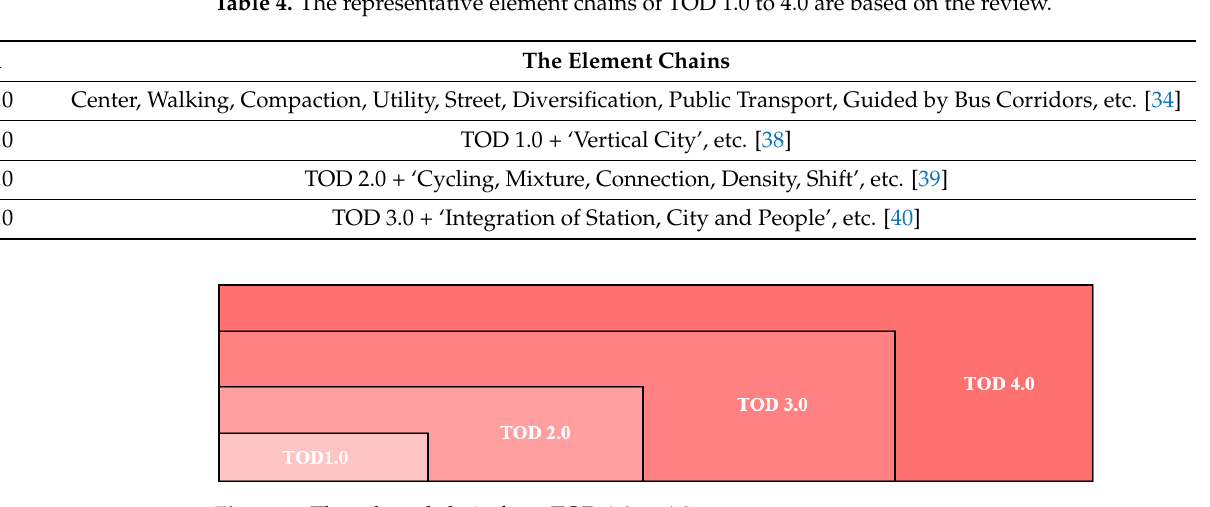
Table 5. The instructions for the blocks and fragments for the DNA Subchain β .